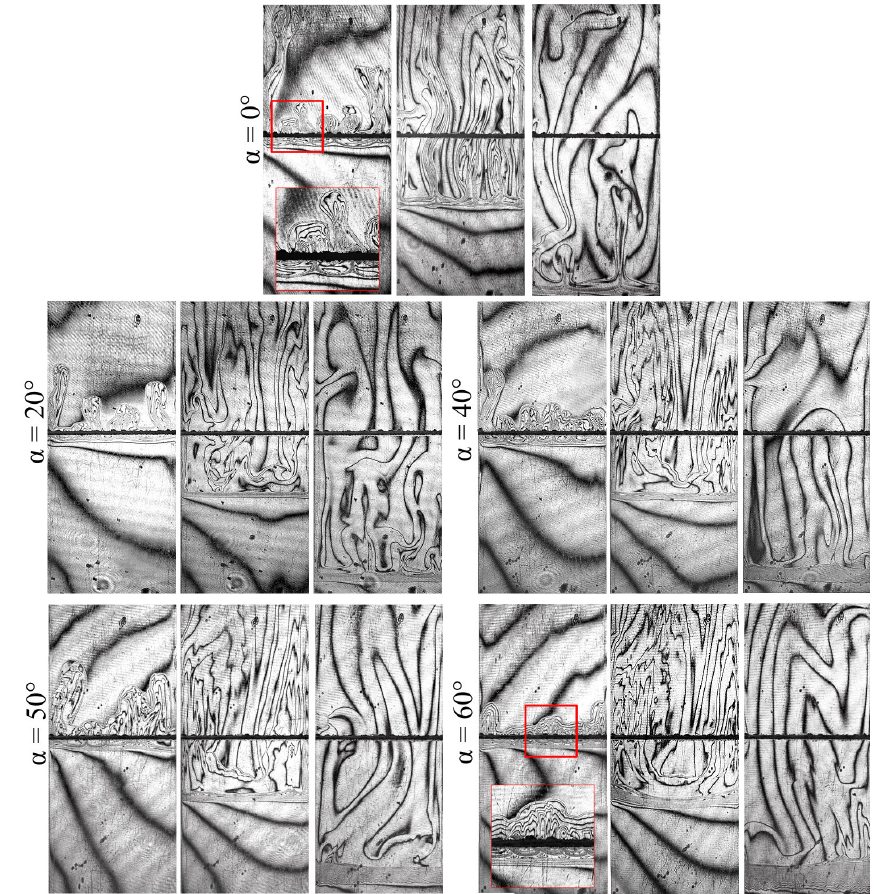
Figure 3. Five series of interferograms demonstrating the dynamic development of the chemocon- vective flow at different angles of the slot inclination. Each series contains three frames obtained for consecutive times: 7, 180, and 1020